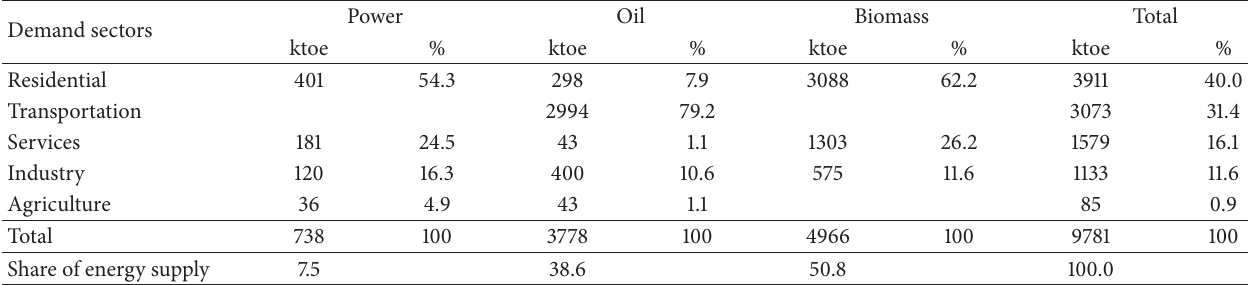
Figure 1: Sankey diagram of USA. Source: [5]. Data is based on DOE/EIA-0035(2015-03), March 2014. If this information or a reproduction of it is used, credit must be given to the Lawrence Livermore National Laboratory and the Department of Energy, under whose auspices the work was performed. Distributed electricity represents only retail electricity sales and does not include self-generation. EIA reports consumption of renewable resources (i.e., hydro, wind, geothermal, and solar) for electricity in BTU-equivalent values by assuming a typical fossil fuel plant “heat rate.” The efficiency of electricity production is calculated as the total retail electricity delivered divided by the primary energy input into electricity generation. End-use efficiency is estimated as 65% for the residential and commercial sectors, 80% for industrial sector, and 21% for the transportation sector. Totals may not equal sum of components due to independent rounding. LLNL-MI-410527. Table 1: Sudan energy balance 2012